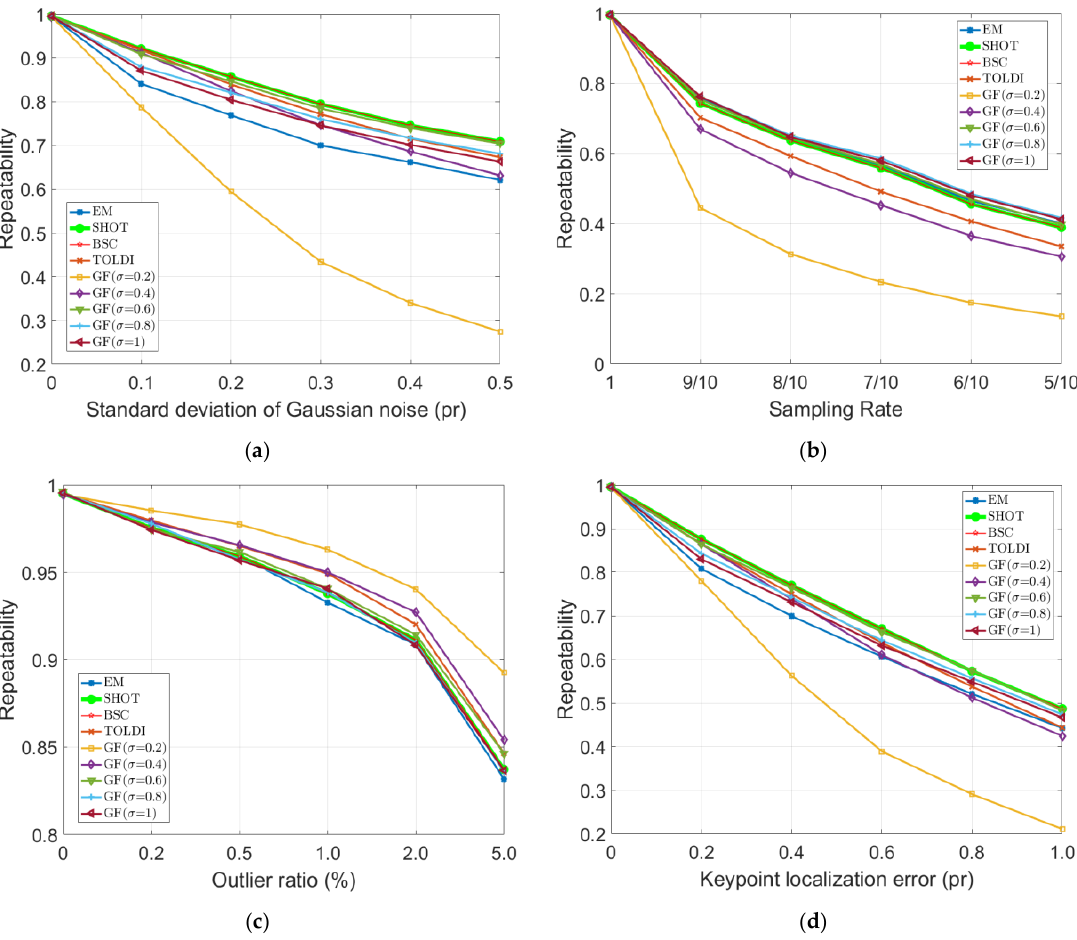
Figure 4. The repeatability of LRF obtained by the five weighting methods with respect to four kinds of nuisances, including ( a ) Gaussian noise, ( b ) point density variation, ( c ) shot noise, and ( d ) keypoint localization error.